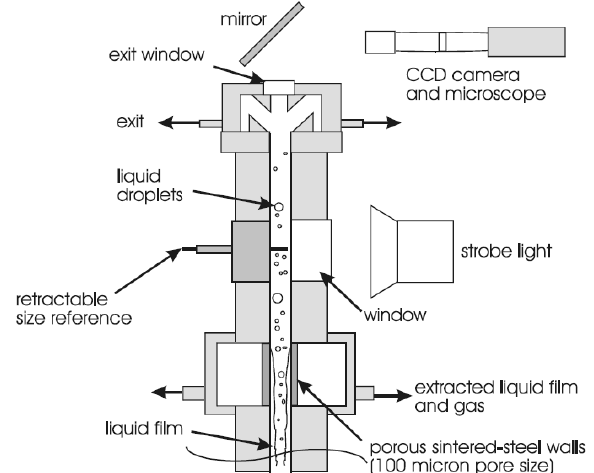
Figure 8. Optical setup of the droplet size measurement, adapted with permission from [165], 2002, Elsevier.